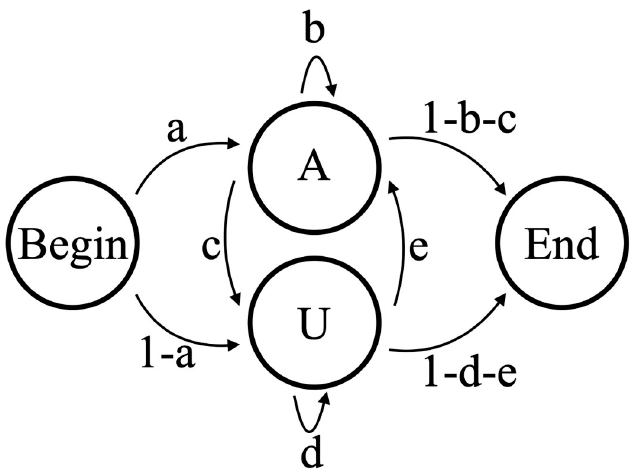
Fig 8. Model B2. 2-state model of nontemplated tail addition (B2), with five independent transition parameters a,b,c, d, and e. This model cannot be used to distinguish between in-tail and ex-tail